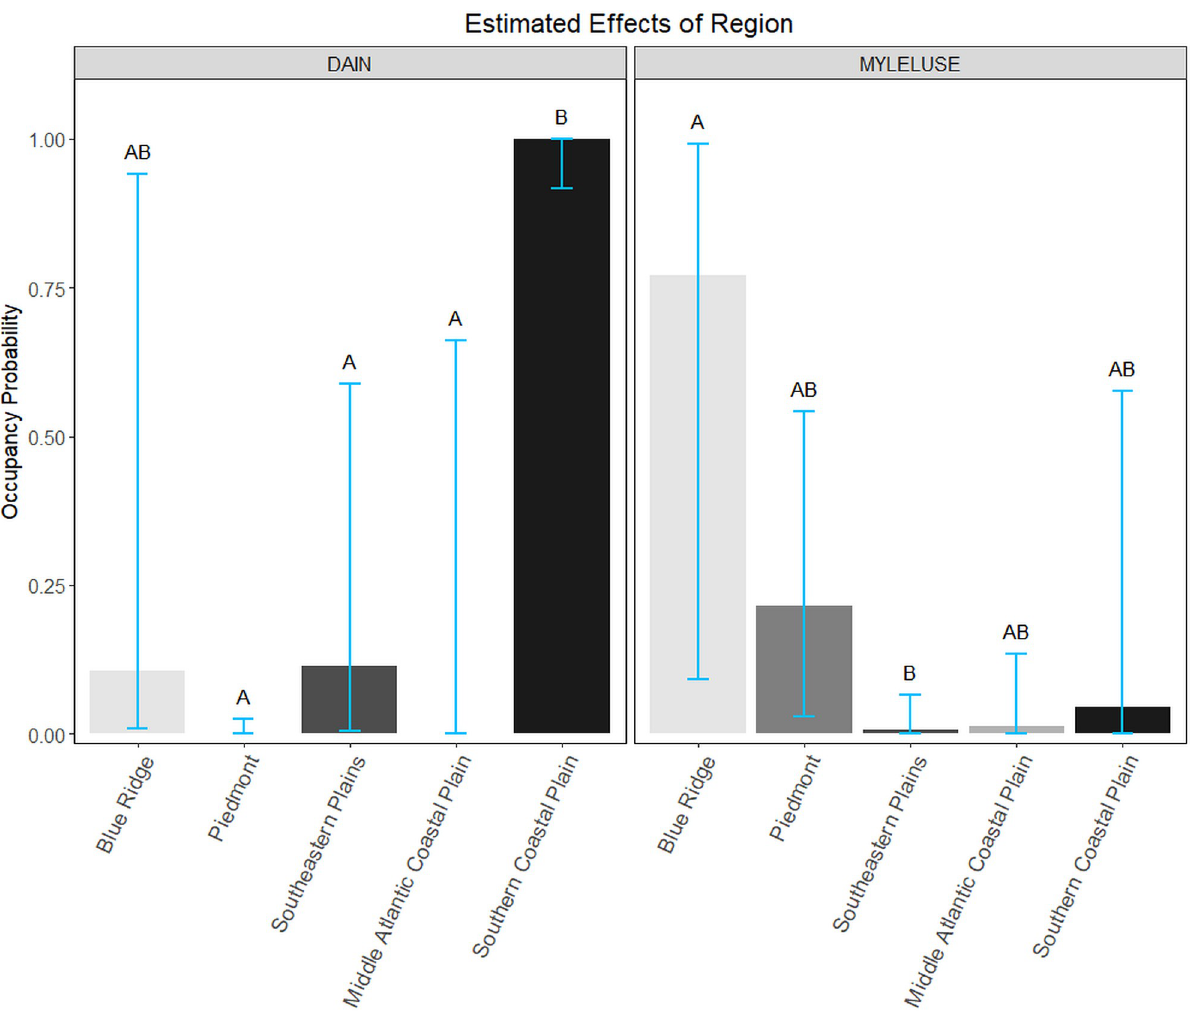
Fig 2. Mean estimated probability of occupancy of northern yellow bats (DAIN) and small-footed bats, little brown bats, and northern long- eared bats combined (MYLELUSE) within each ecoregion of South Carolina, May-July 2015–2016. Blue bars indicate 95% credible intervals. Within species, regions which share a letter above their intervals are not significantly different from one